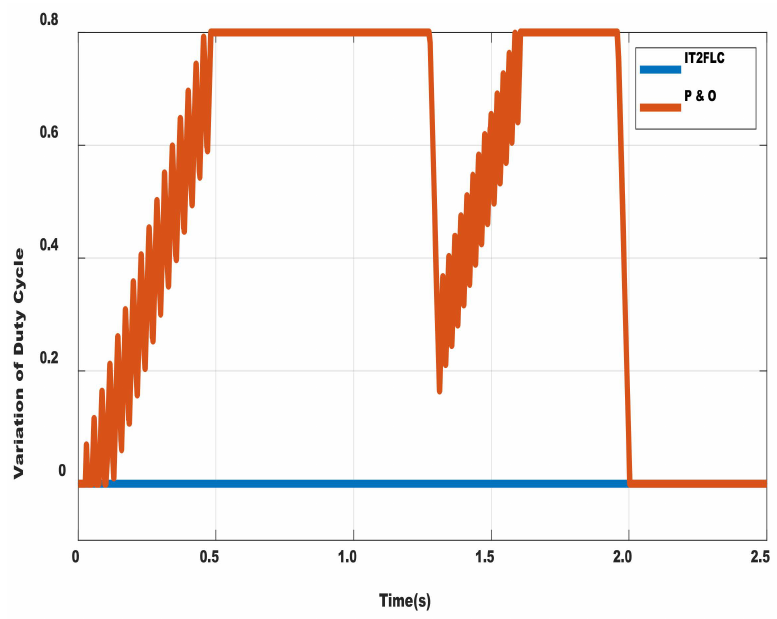
Figure 24. Duty cycle response for boost converter at variable inputs.